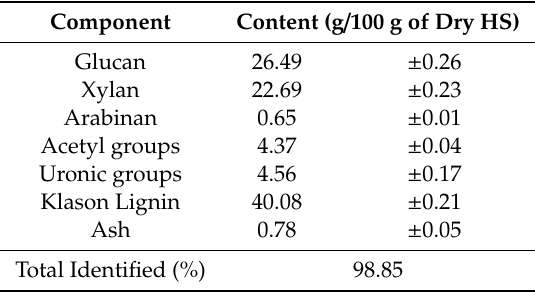
Table 1. Composition of HS expressed as g of component per 100 g of oven-dried raw material. The values are reported as the average of triplicate measurements ± standard